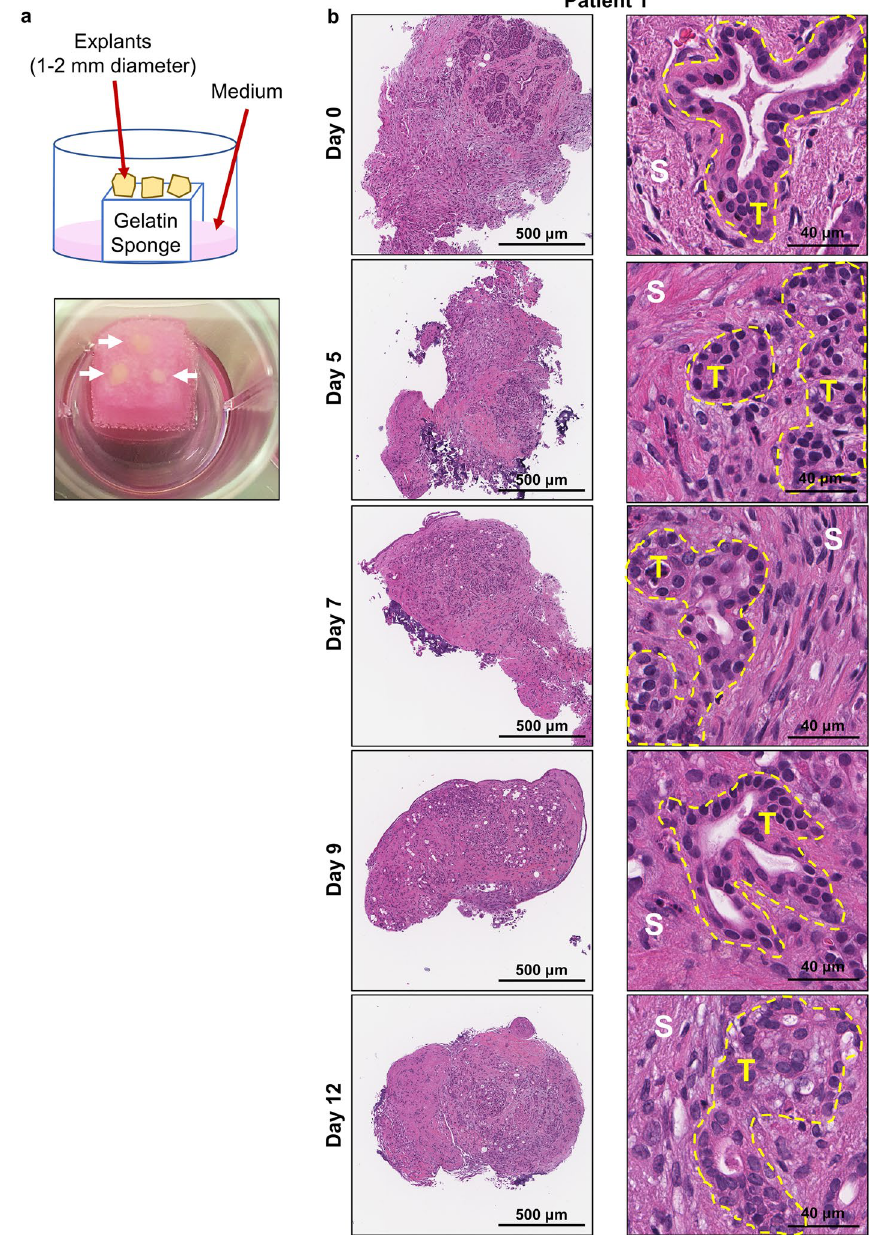
Figure 1. Tumour and stromal architecture are maintained in human patient derived pancreatic ductal adenocarcinoma explants for 12 days of culture. (a) Schematic showing the set-up of the ex vivo culture method and a representative photo of a gelatin sponge containing three PDAC explants in a well of a 24-well plate. White arrows point to the three explants on the gelatin sponge during culture. (b) Representative H&E images of patient 1 explants at low and high magnification from days 0–12. Tumour elements are outlined in yellow and compartments labelled as tumour (T) and stroma